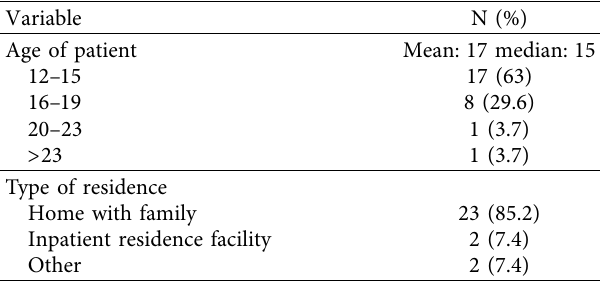
Table 1: Demographic